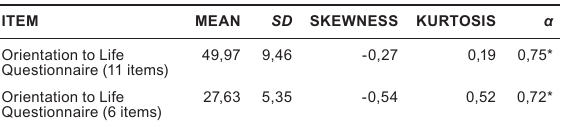
table 3 Descriptive statistics of the OLQ